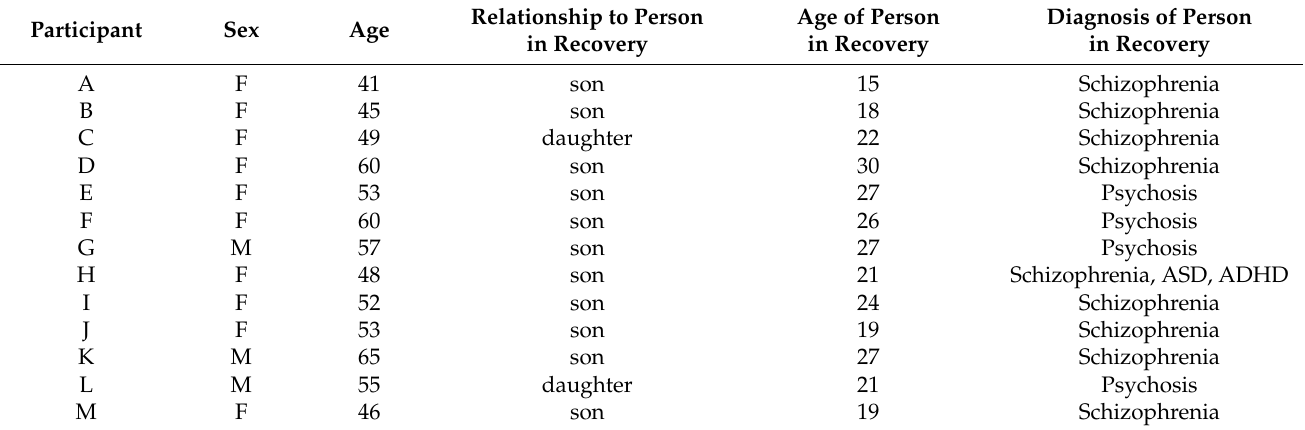
Table 1. Profile of the participants who submitted photographs and were selected for data